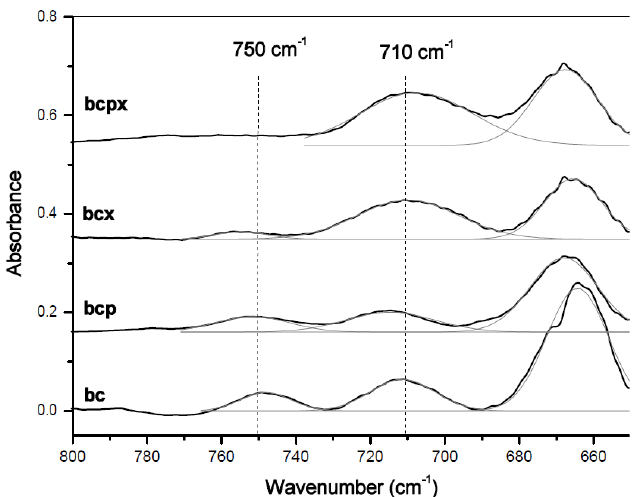
Figure 4. Comparison of FTIR spectra of bacterial celluloses cultured in presence of pectin (BCP), xyloglucan (BCX), both pectin and xyloglucan (BCPX) or neither (BC) in the range 800–650 cm −1